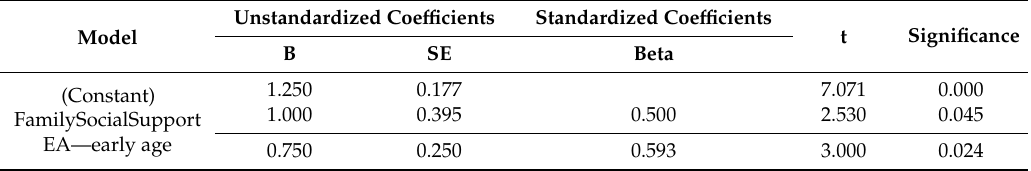
Table 5. Linear regression model for attitude.